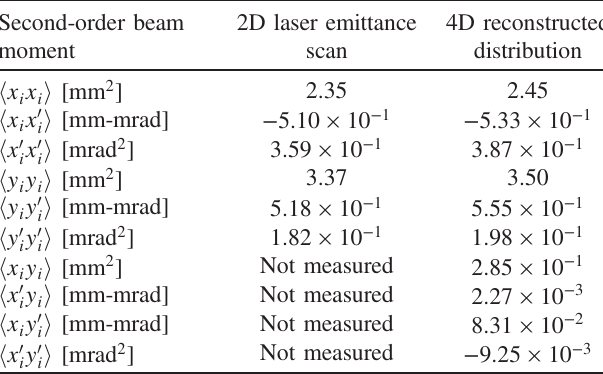
TABLE III. Second-order moments of the beam ’ s 4D transverse phase space distribution from (i) 2D laser wire scans and (ii) four- scan 4D MENT